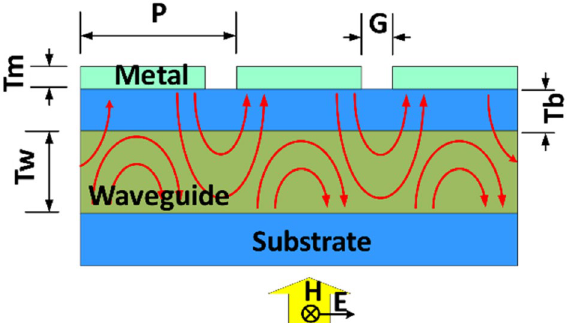
Figure 1. Schematic of Plasmonic Grating Filter with buried slab waveguide with illustrative E-field lines in red and the annotated parameters. Period of grating is P (260 nm to 450 nm at 10 nm steps), gap between fingers is G (60 nm), thickness of the metal is Tm (40 nm), thickness of the waveguide is Tw (90 nm) and distance between grating and waveguide is Tb (60 nm). The metal is Aluminum, the waveguide is made of Silicon Nitride layer buried in Silicon Dioxide and substrate is Silicon Dioxide.